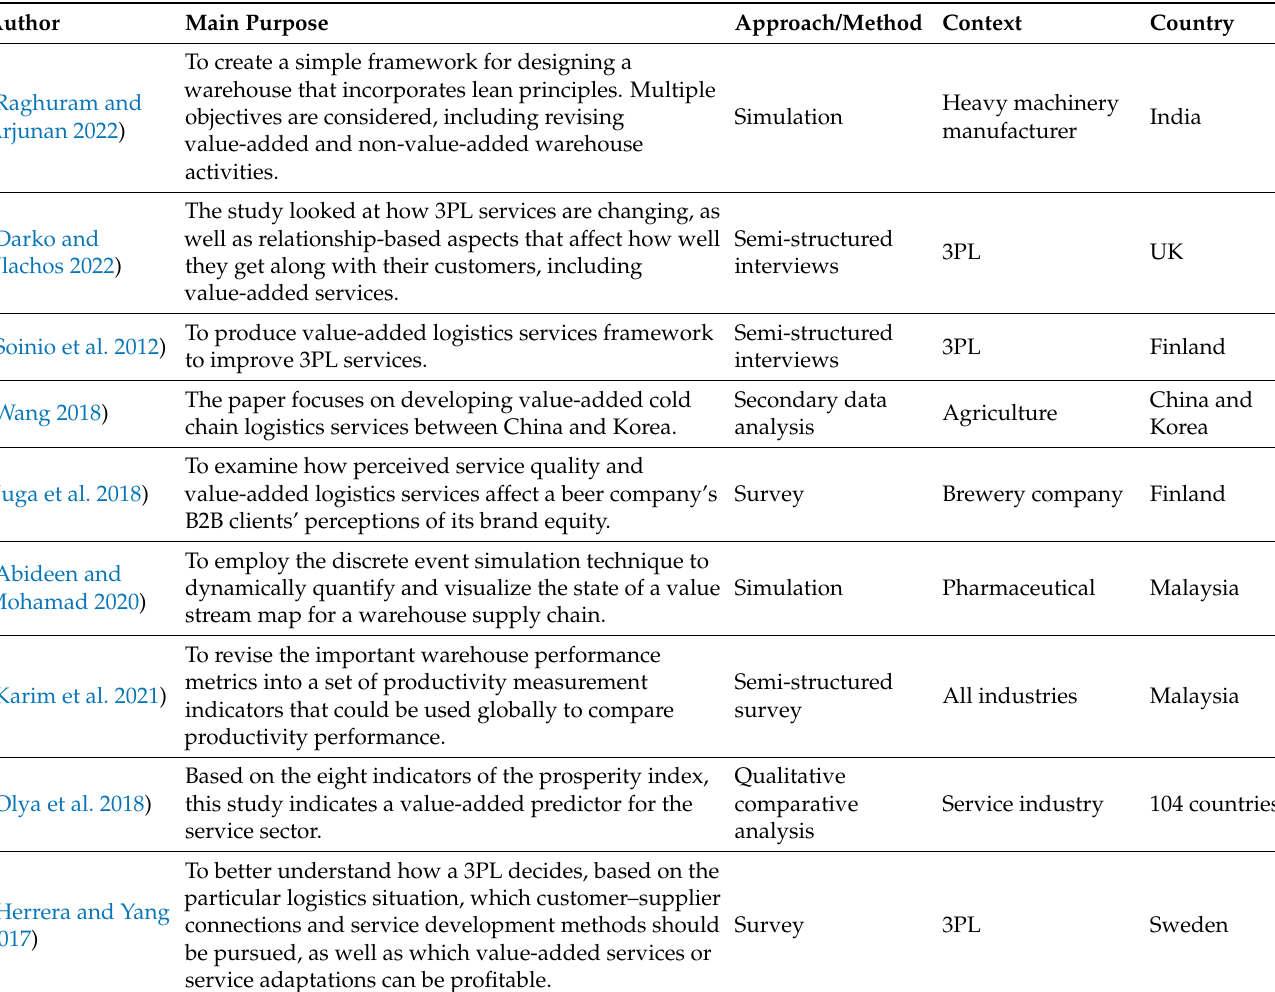
Table 2. Summary of warehouse value-added-services-related